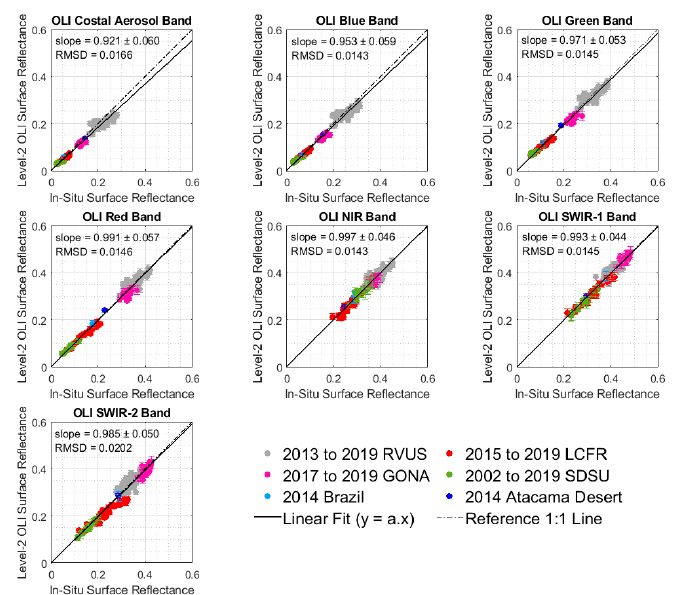
Figure 17. Scatterplots by band of Landsat-8 OLI Level-2 surface reflectance data product versus surface reflectance values derived from in-situmeasurement. Remote Sens. 2020 , 12 , x FOR PEER REVIEW 25 of 30